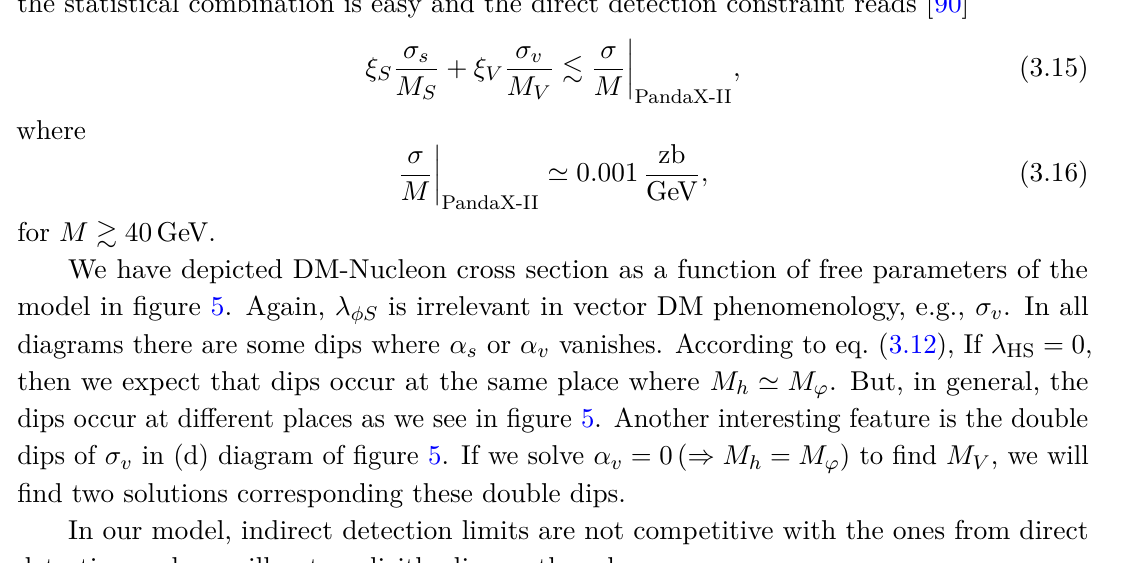
= 1800 GeV , M = 600 GeV , g = 0 . 2 , λ = 0 . 5 S V φS